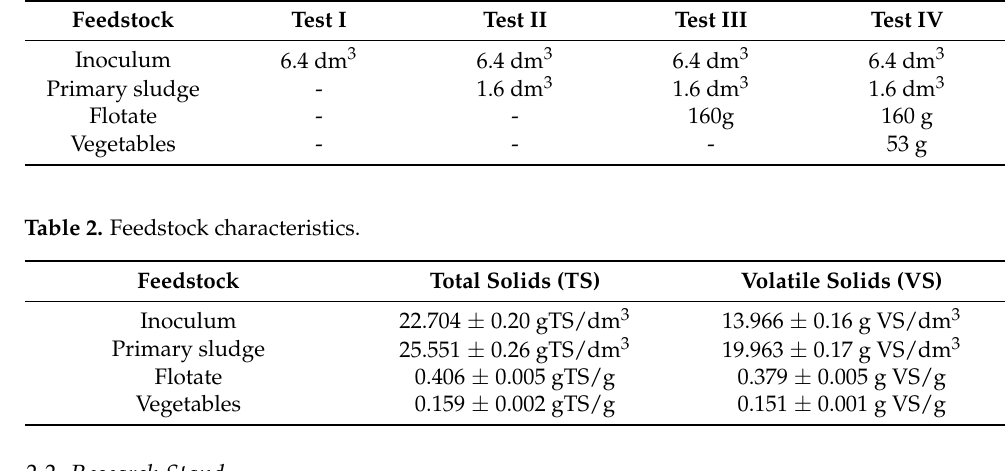
Table 1. The feedstock composition in the reactors for individual tests.